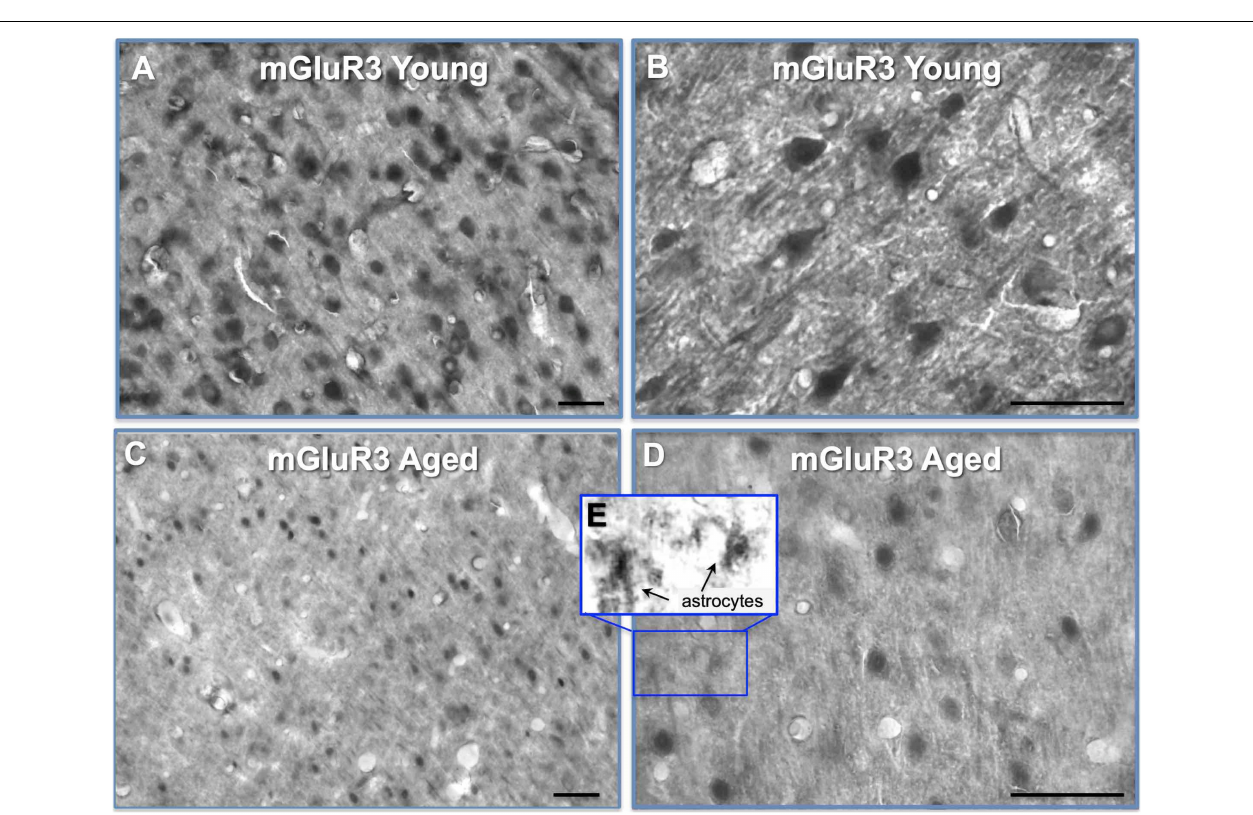
FIGURE 3 | mGluR3 labeling by IHC in young and aged rat layer II/III PL PFC. (A) Immunolabeling for mGluR3 in young rat layer II/III PL mPFC revealing high density of mGluR3 expression in multiple cell-types. (B) High-magnification micrograph showing mGluR3 expression in young rat layer II/III PL mPFC in excitatory pyramidal cells, and smaller putative astrocyte-like cells. The neuropil is also characterized by punctate-like labeling for mGluR3. (C) Expression of mGluR3 in aged rat layer II/III PL mPFC with a marked decrement in the density of labeling across cell-types. (D,E) High-magnification micrograph showing mGluR3 expression in aged rat layer II/III PL mPFC with sparser labeling, and decreased labeling in dendritic arbors, as well as possible labeling of reactive astrocytes, magnified in insert (E) . Scale bars: 50 µ